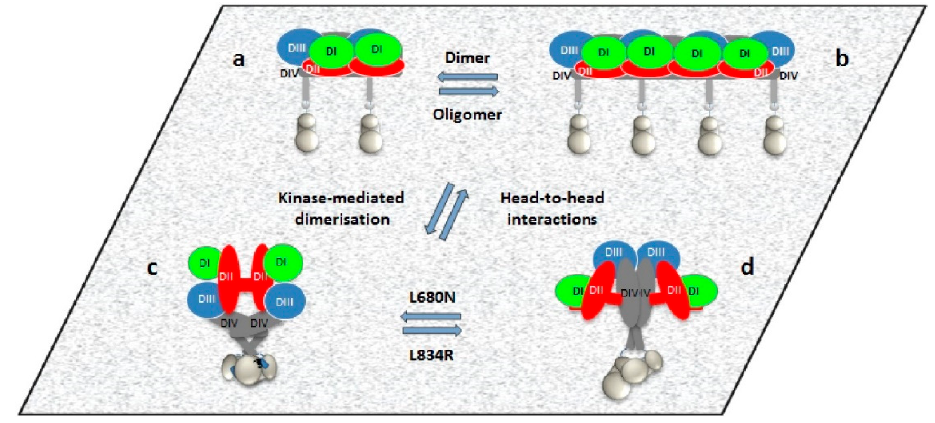
Figure 11. Cartoon models of ligand-free EGFR species on the cell surface (from Zanetti-Domingues et al. (2018) [120]). ( a , b ) Autoinhibited ligand-free receptors form dimers and larger oligomers via the extracellular head-to-head interaction. The intracellular domains do not interact; ( c , d ) Kinase-mediated dimerization outcompetes the head-to-head interaction and forms two types of receptor dimers existing in equilibrium. The equilibrium is shifted by the kinase-domain mutations L680N and L834R.